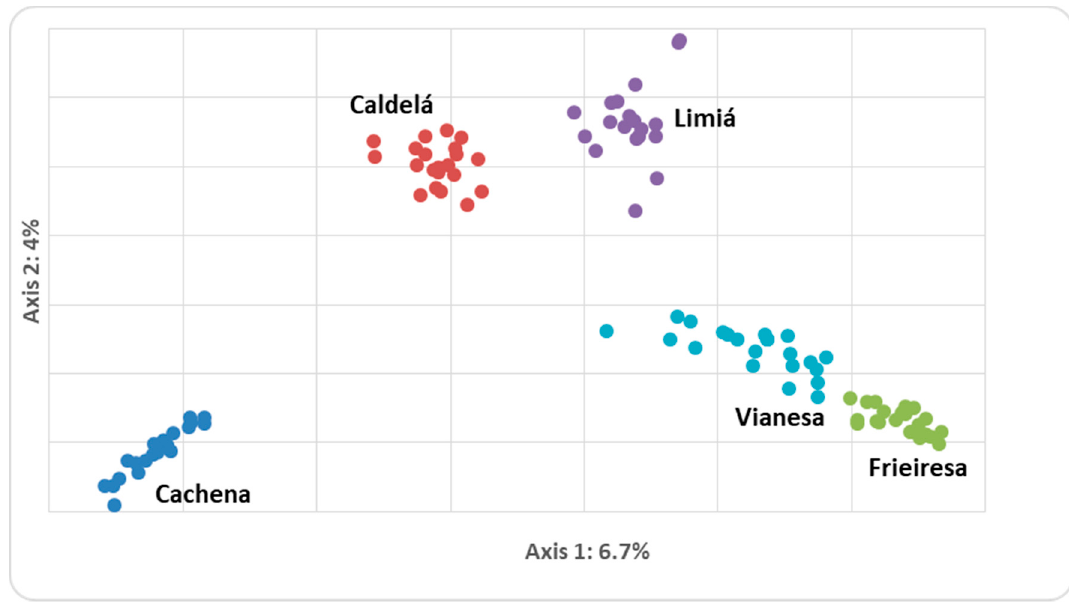
Figure 2. Spatial representation of the Morenas Gallegas bovine breeds analyzed from the first two axes obtained in the factorial analyses of correspondence.